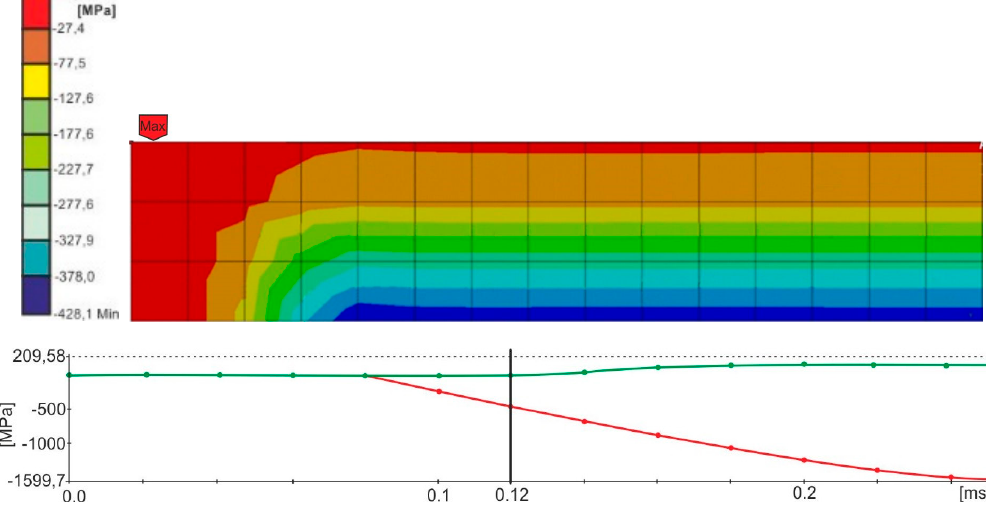
Figure 8. Normal stress distribution on the half of the frontal surface of the overlay, for a computation time of 0.12 ms, loaded with energy 10 J, at a speed of 2.42 m/s .